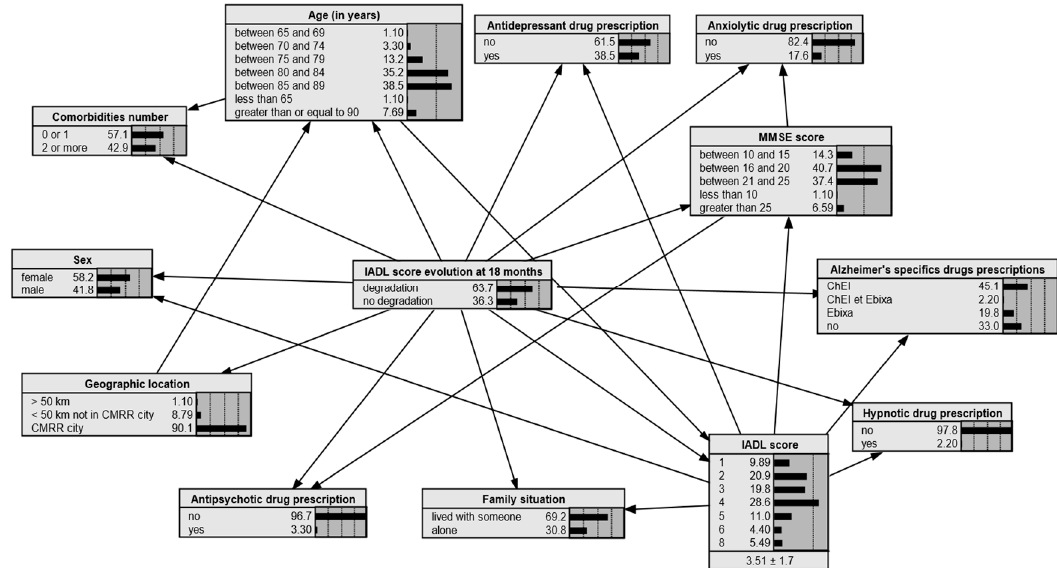
Figure 2. Structure of the T18 Bayesian Network. CMRR = University Clinical and Research Memory Center of Lyon. IADL = instrumental activities of daily living. MMSE = Mini-mental state examination. ChEI = cholinesterase inhibitor. EBIXA = Name of the specialty memantine. The predictions of each model obtained after 10-fold cross-validation are presented in Figure 3.